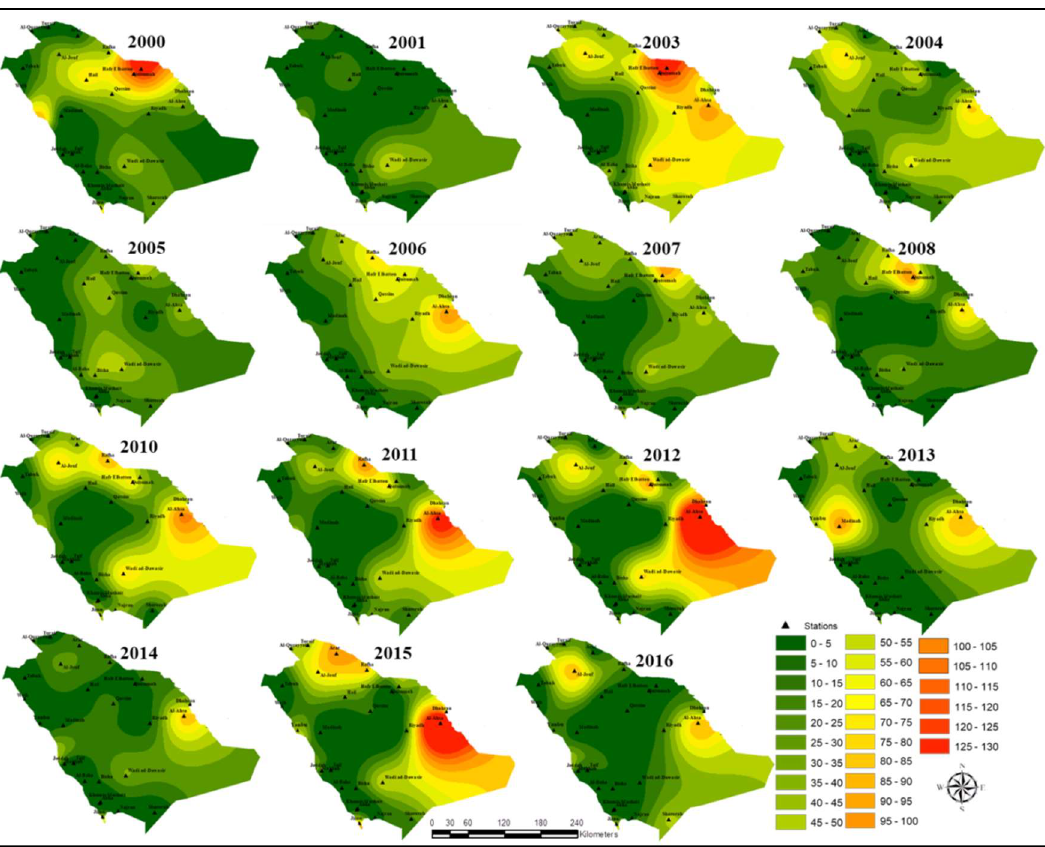
Figure 5. Spatially interpolated dust storm frequency per year over Saudi Arabia for the period 2000–2016. Note that the highest frequency of total dust event occurrences varies from year to year with a concentration mostly in the east region.